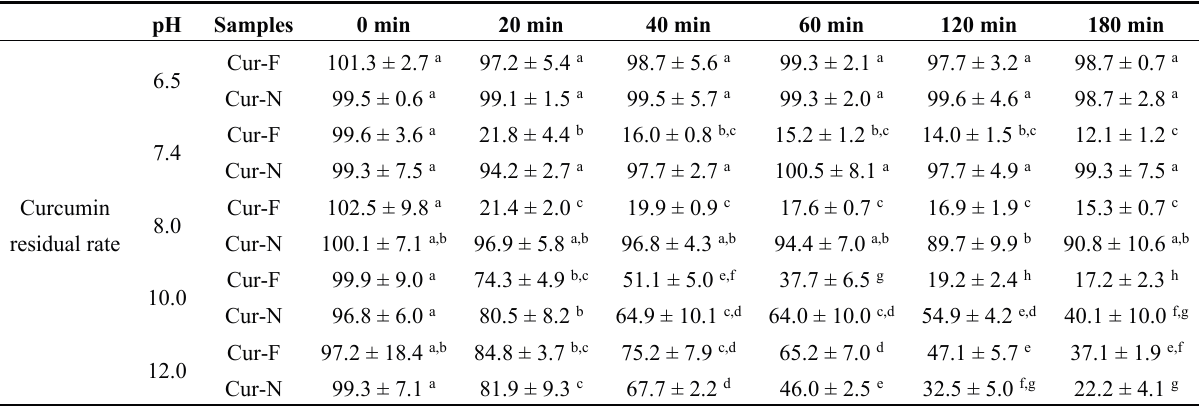
Data were presented as mean ± SD, n = 3. Different letters in the same parameters indicate a significant difference in the Duncan test ( p ˂ 0.05). Cur-F and Cur-N represent free curcumin and curcumin nanoliposomes,